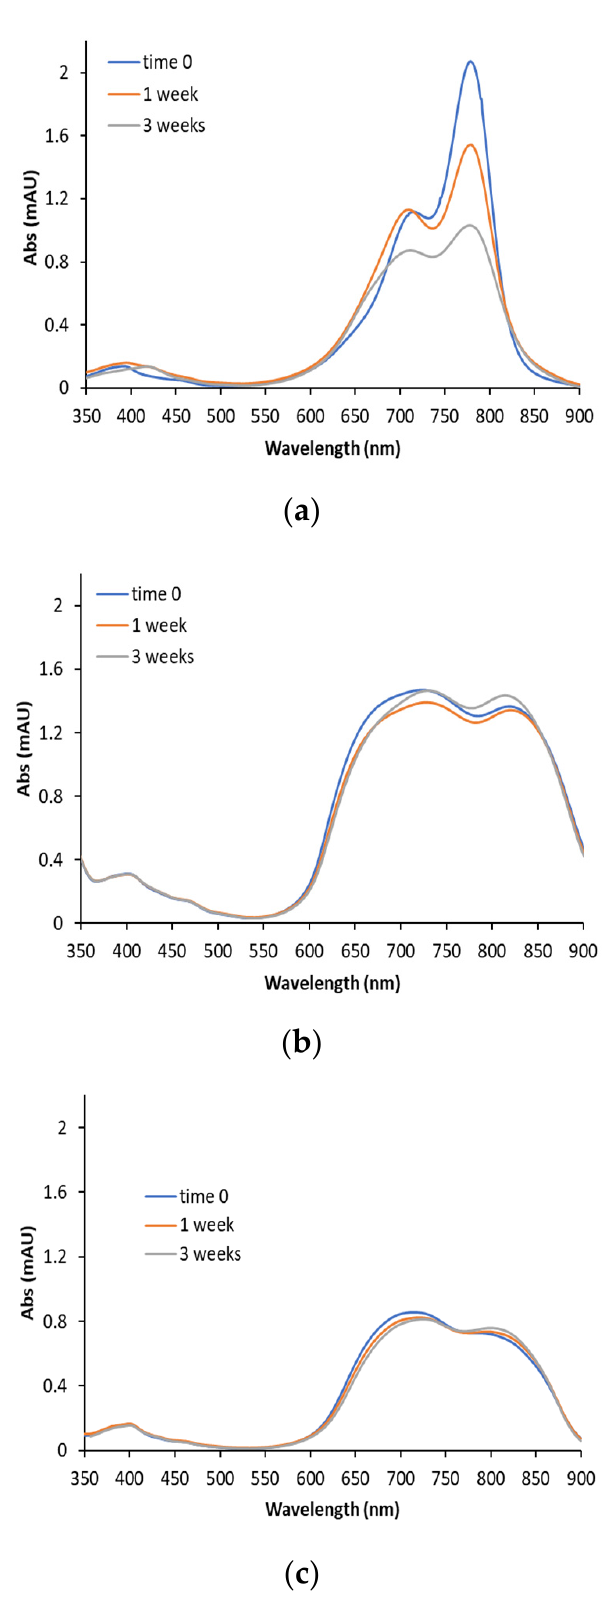
Figure 3. UV-Vis spectra registered at the preparation (time zero) and after 1 and 3 weeks at 4 °C for ICG in aqueous solution ( a ) and for ads-ICG NPs ( b ) and enc-ICG NPs ( c ).